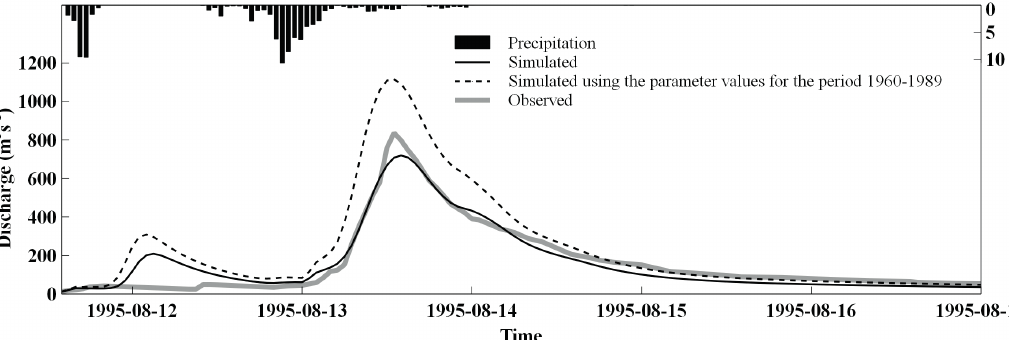
Fig. 3 Example (11 August 1995–17 August 1995) of observed hydrograph and simulated hydrographs using the parameter values for the period 1990–2000 (black line) and the period 1960–1989 (dotted line),